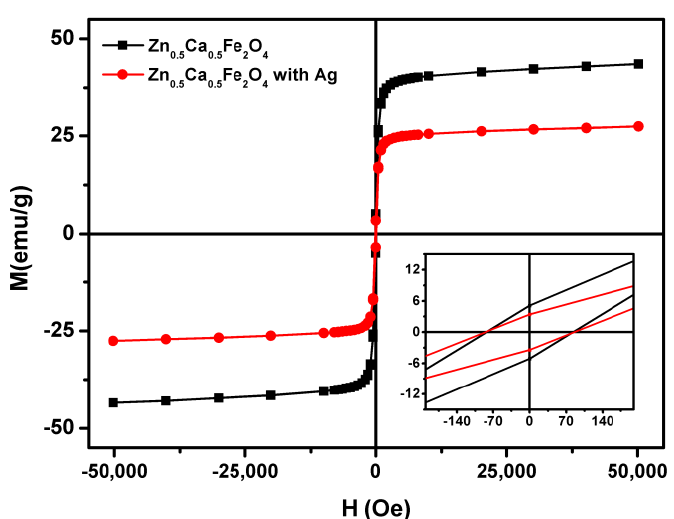
Figure 4. Hysteresis loop of Zn 0.5 Ca 0.5 Fe 2 O 4 and Zn 0.5 Ca 0.5 Fe 2 O 4 with Ag nanoparticles at room temperature. Inset: Enlargement in the low field region of the loop. Table 2. Coercive field (C), saturation magnetization (M s ), remanent magnetization (M r ), and ratio M r /M s for zinc/calcium ferrites at room temperature.